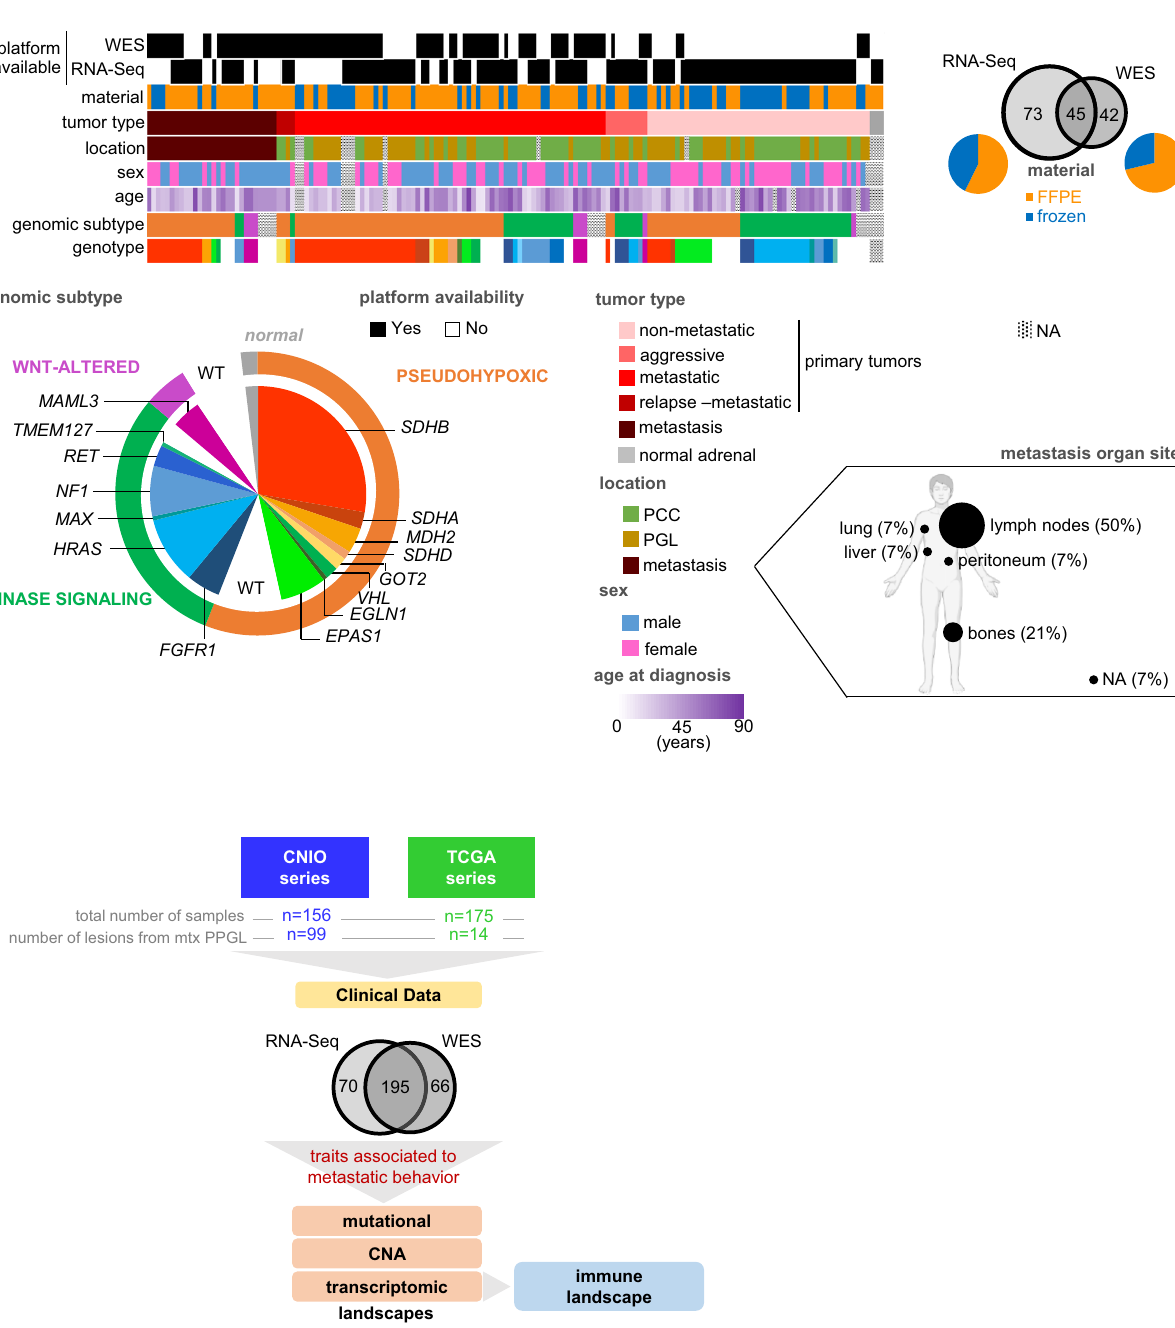
Fig. 1 | Series description and study work fl ow. a Characteristics of the CNIO cohort used for WES and RNA-Seq analysis. Characteristics shown are: platform available(WESandRNA-Seq),preservationofmaterial(FFPEorfrozen),tumortype